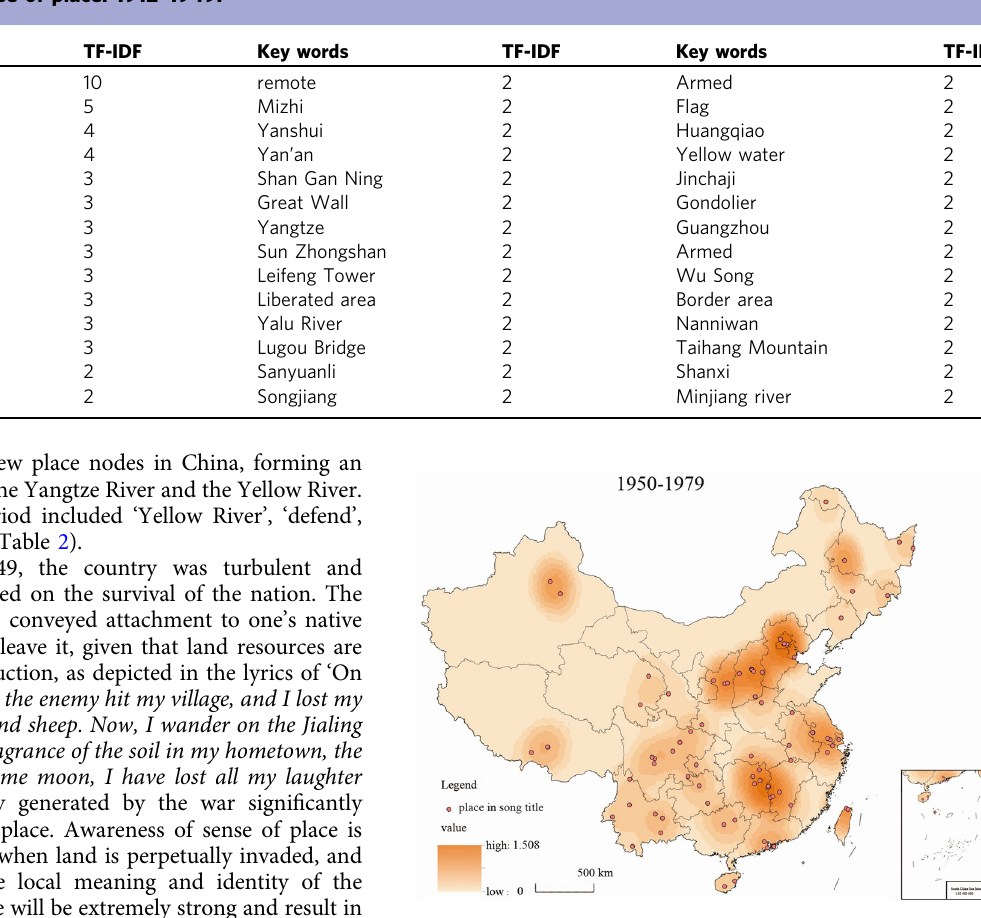
Fig. 3 Kernel density estimation of place in music in 1950 – 1979. Kernel density estimation of place in music titles from 1950 to 1979 indicates that the darker areas are distributed mainly in the Beijing, Shanxi, Shaanxi, Hunan, and Jiangxi provinces. These places are often referred to in song titles, forming a cluster.